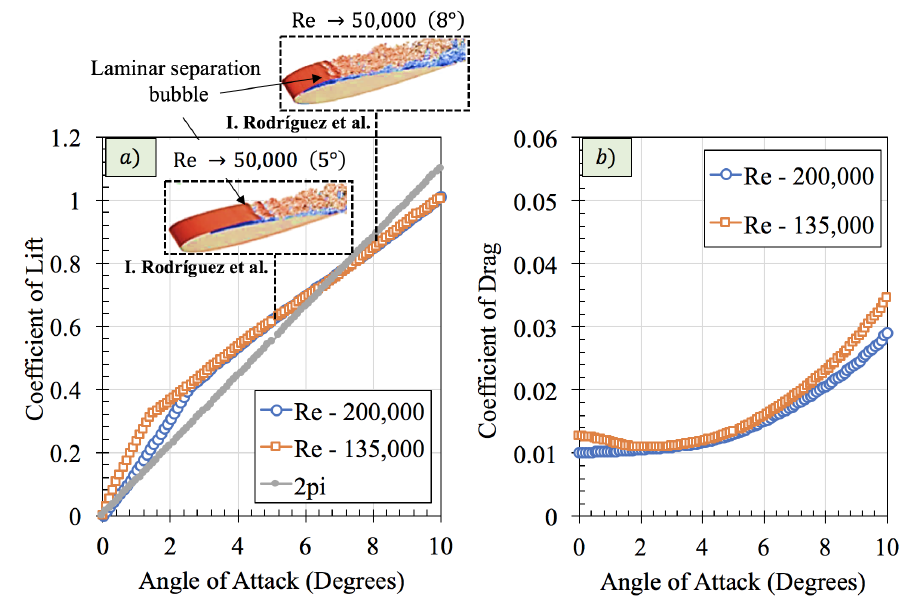
Figure 8. Comparison of ( a ) lift coefficient ( b ) drag coefficient at different Reynolds numbers.